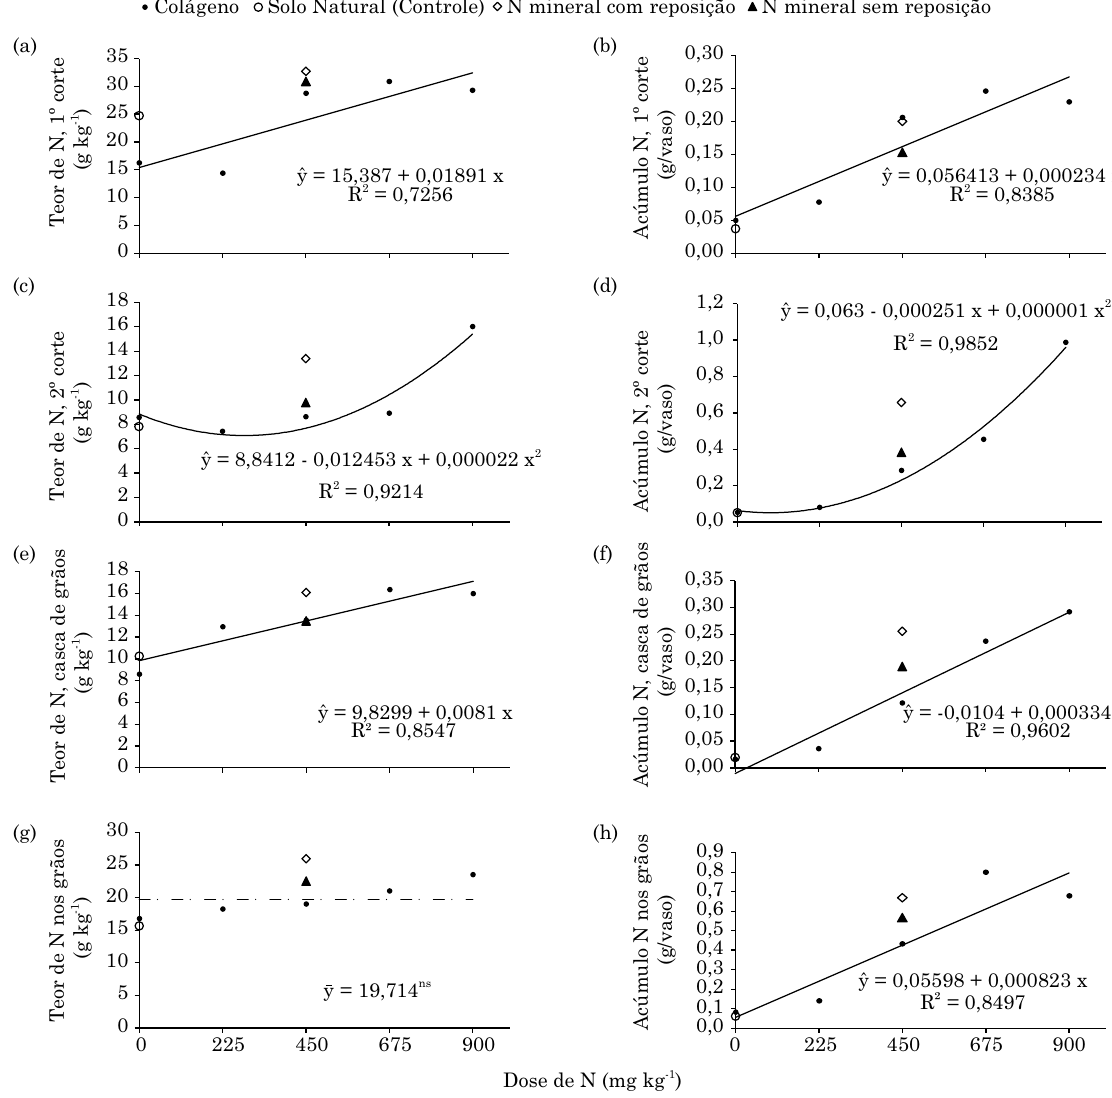
Figura 5. teor e acúmulo de nitrogênio na parte aérea no 1º corte (a, b), no 2º corte (c, d), nas cascas de grãos (e, f) e nos grãos (g, h) em plantas de arroz submetidas a doses de nitrogênio via colágeno de curtume e três tratamentos adicionais, cultivadas em Latossolo Vermelho Distrófico típico.